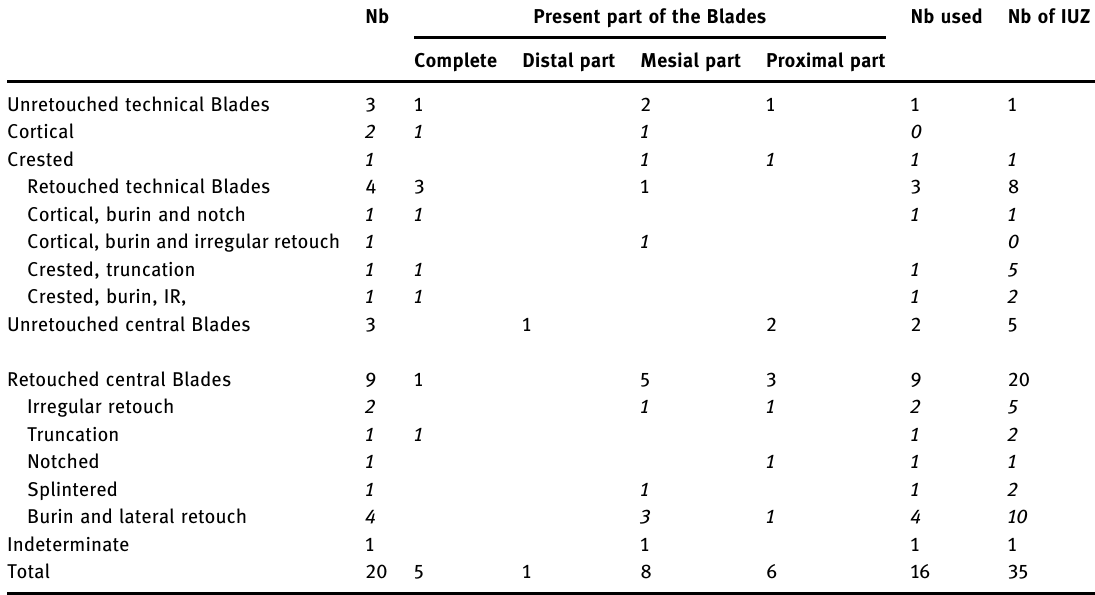
Table 2: Composition of the analysed large Blade samples Nb Present part of the Blades Nb used Nb of IUZ Complete Distal part Mesial part Proximal part Unretouched technical Blades 3 1 Cortical 2 Crested Retouched technical Blades Cortical, burin and notch 1 Cortical, burin and irregular retouch 1 Crested, truncation 1 1 Crested, burin, IR, 1 1 Unretouched central Blades Retouched central Blades Irregular retouch 2 Truncation 1 Notched 1 Splintered Burin and lateral retouch Indeterminate 1 Total